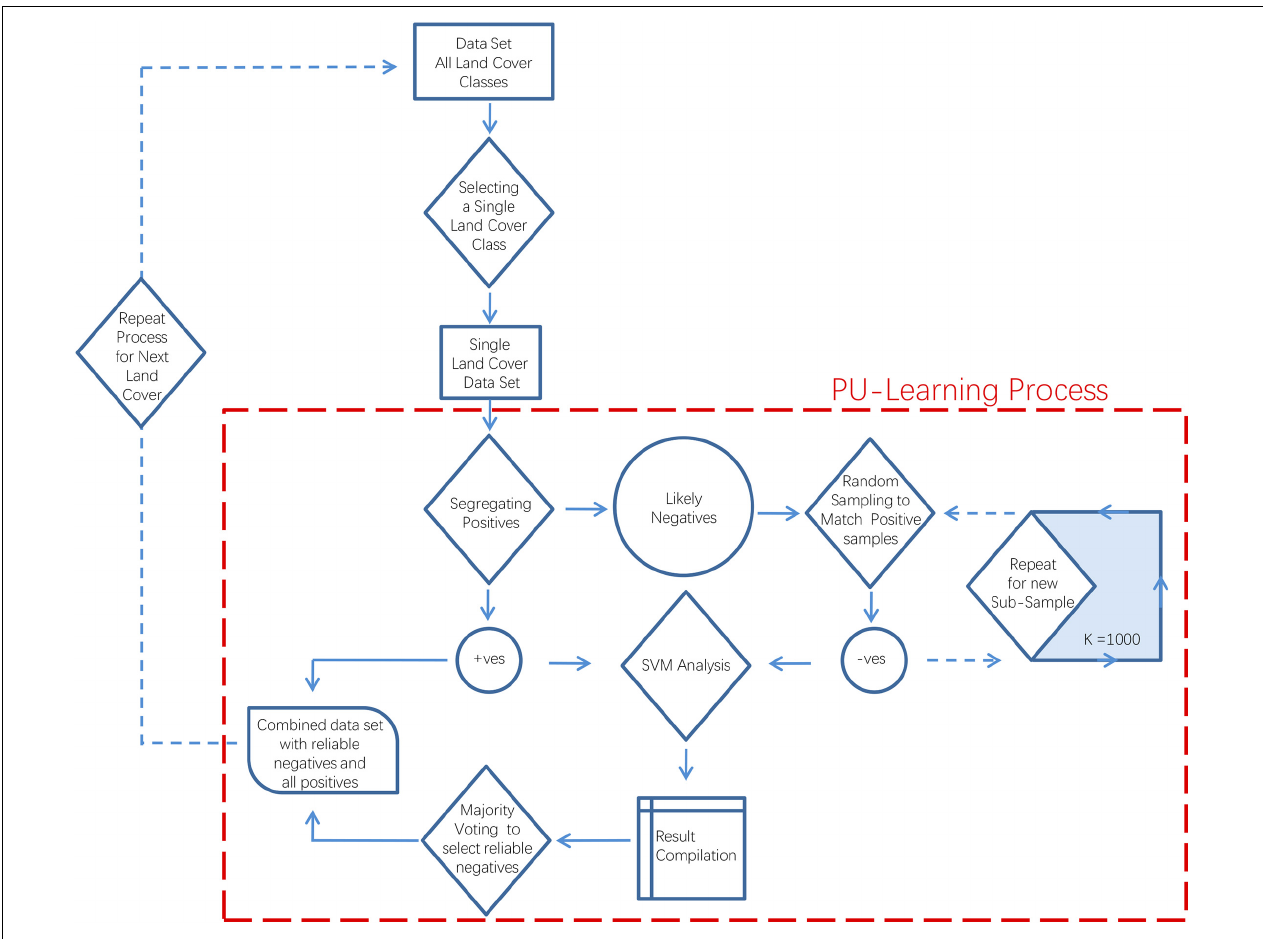
FIGURE 3 | The PU learning